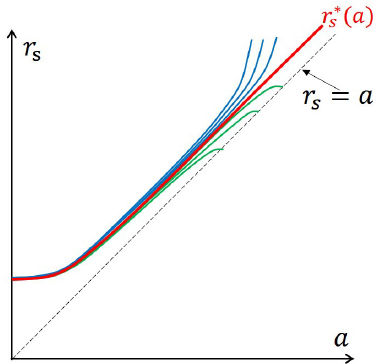
Figure A1. Integral curves of Equation (A2) that start from points satisfying r s ∼ a (cid:29) l p . As Equation (A2) shows, their slopes are positive for r s > a and become zero at a = 0. They